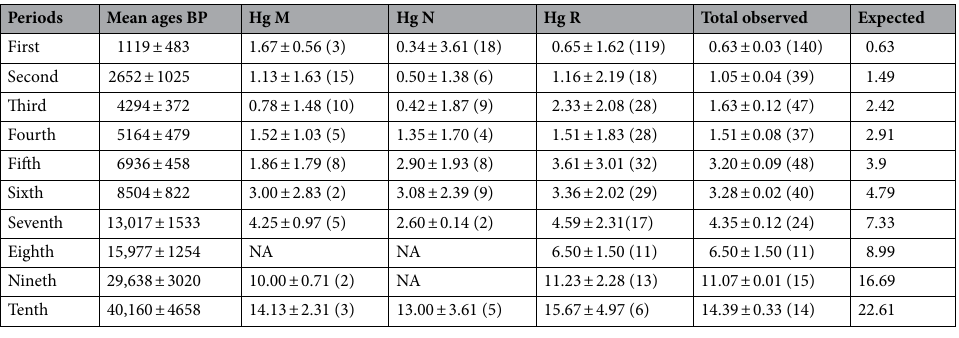
Table 1. Mutation differences between modern and ancient mitogenomes by macrohaplogroup and period. () pairs compared.